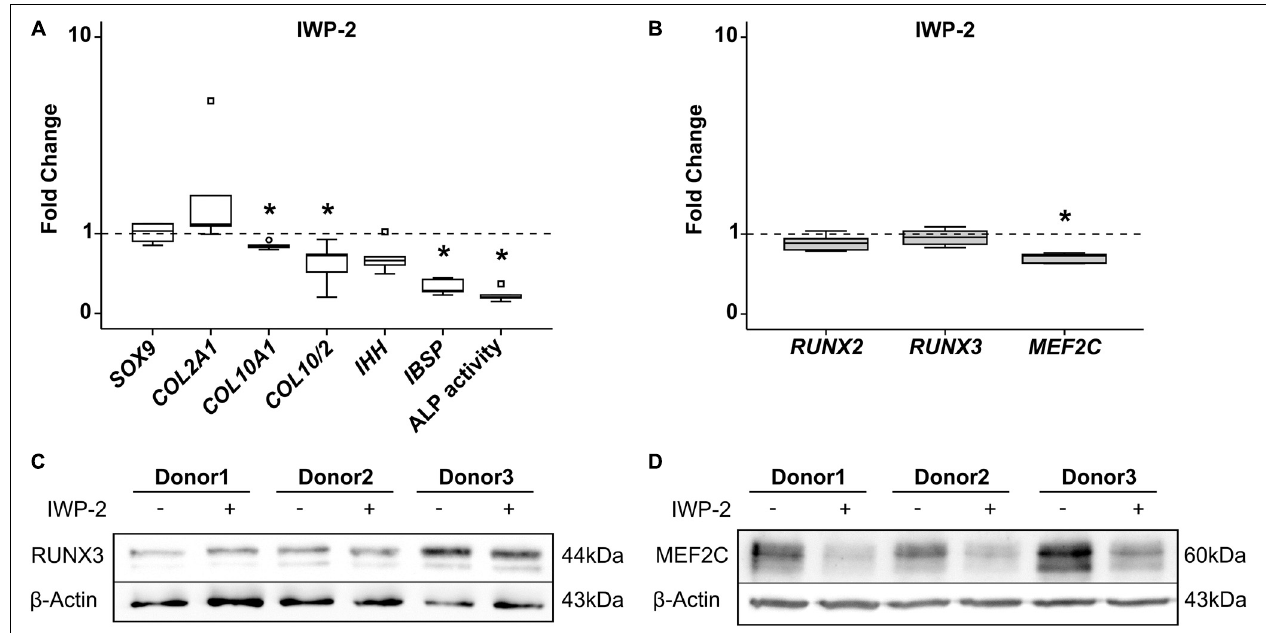
FIGURE 7 | Effects of WNT-signaling inhibition on RUNX2, RUNX3, and MEF2C. MPC pellets were subjected to chondrogenic induction for 5 weeks and treated with 2 µ M IWP-2 or the corresponding amount of DMSO from day 14 ( n = 5 donors). Expression of indicated genes was determined by qRT-PCR (A,B) , and levels were referred to reference genes HNRPH1 and CPSF6 . ALP activity was quantified in culture supernatants (A) . Expression levels of indicated genes and ALP activity are referred to DMSO cultures (dashed lines). Box plots were generated as described in Figure 1 , outliers are depicted as ◦ , and extreme values as (cid:3) . *, p ≤ 0.05, Mann–Whitney U test. RUNX3 (C) and MEF2C (D) protein levels were determined in samples treated with IWP-2 (+) or with DMSO (–) by Western blot analysis, β -actin levels were determined as internal reference. Three representative experiments are